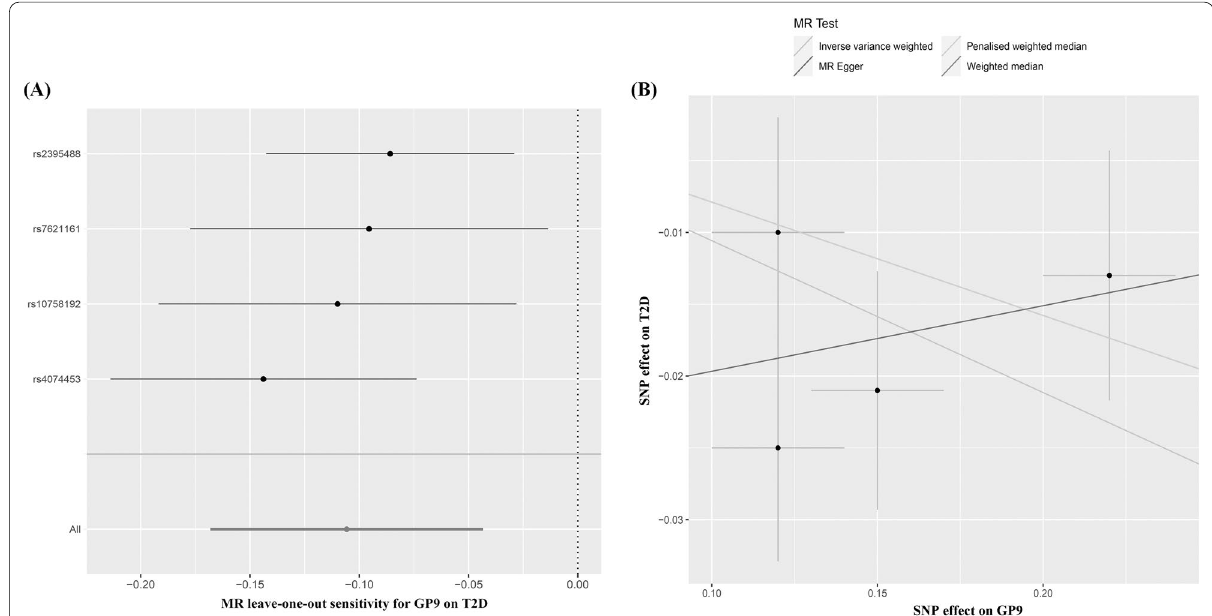
Fig. 4 Leave-one-out plots and scatter plots of IgG N-glycans of GP9 on T2D in the European population. Leave-one-out plots show the estimate of GP9 on T2D after the corresponding SNP was excluded. Scatter plots show the per-allele association with T2D plotted against the per-allele association with one standard deviation of GP9 (vertical and horizontal black lines presenting the 95% CI for each SNP), with the slope of each line corresponding to estimate the effect per method. SNP, single nucleotide polymorphism; GP, glycan peak; T2D, type 2 diabetes; IgG, immunoglobulin